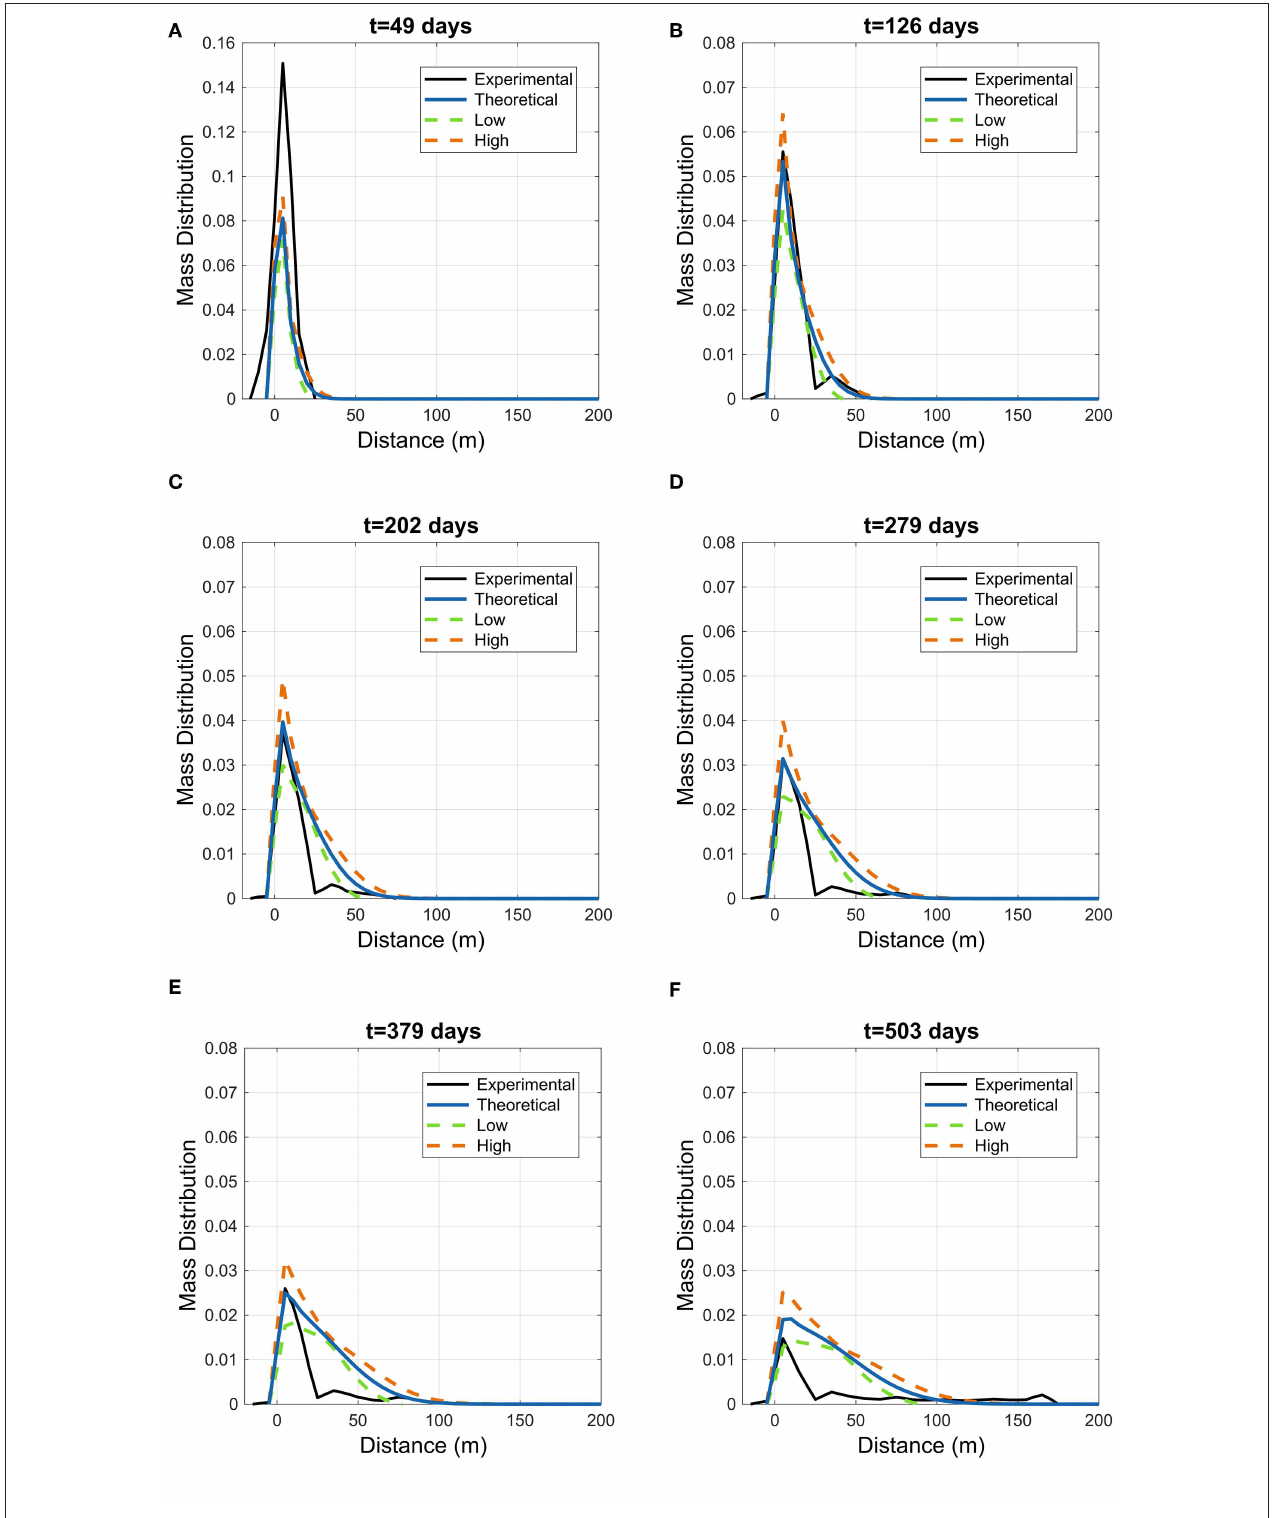
FIGURE 7 | Parametric uncertainty: the experimental longitudinal mass distribution at the MADE-1 experiment for the six snapshots presented by Adams and Gelhar (1992), black lines; the blue solid line depicts the theoretical m ( x ; t ) (15), while the dashed lines represent the bounds for parametric uncertainty m + σ m (orange dashed line, “High”) and m − σ m (green dashed line, “Low”). G 1 in solutions (15) is given by (C.3).